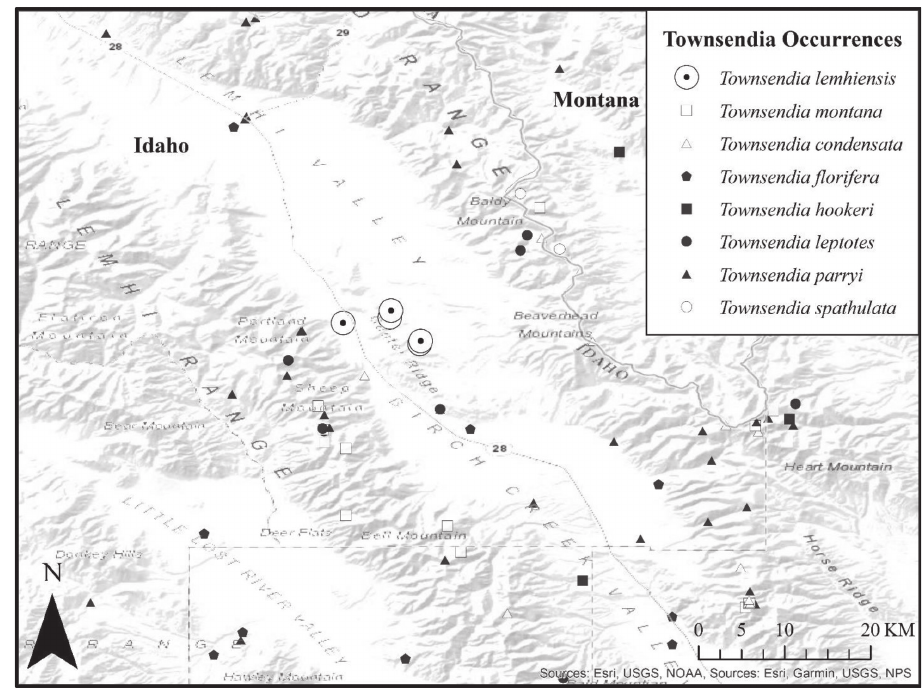
Figure 3. Occurrence records of Townsendia lemhiensis and other nearby Townsendia spp.